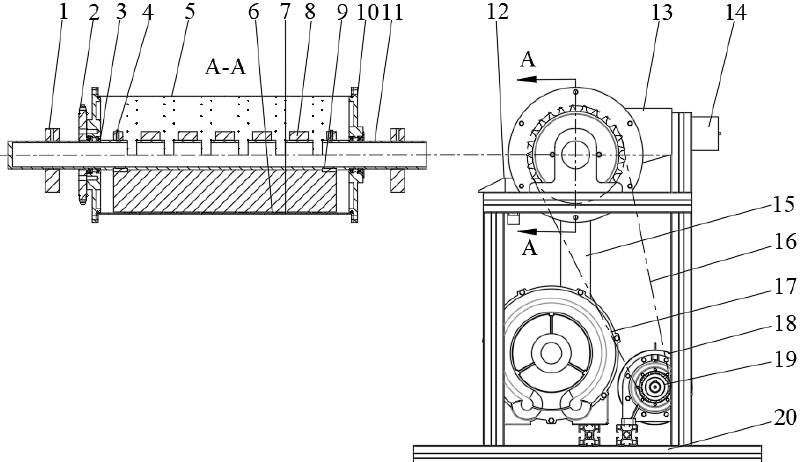
Figure 2. Schematic diagram of the air ‐ absorbing staggered roller type precision seed discharger structure. 1. Fixed support; 2. Large sprocket; 3. Bearing; 4. Fastening screw; 5. Drum; 6. Absolute pressure block; 7. Spring; 8. Inner drum; 9. Standard flat key; 10. End cover; 11. Negative pressure shaft; 12. Seed thrower; 13. Seedbox; 14. Bin wall vibrator; 15. Steel wire hose; 16. Chain; 17. Whirlpool fan; 18. Reducer motor; 19. Small sprocket; 20. Machine frame. A-A. The cross-sectional view of the seeding drum.